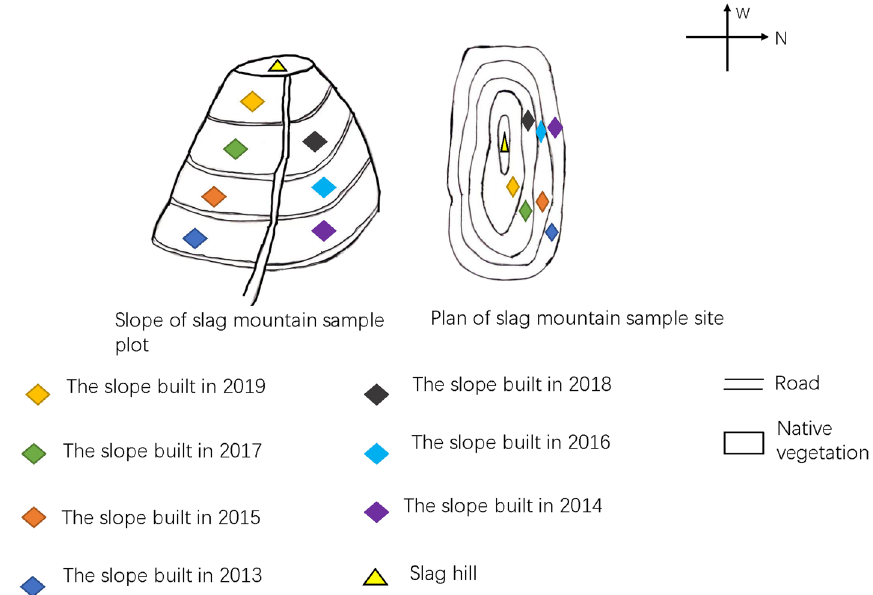
Fig. 1 The geographical location of the layout of the sample